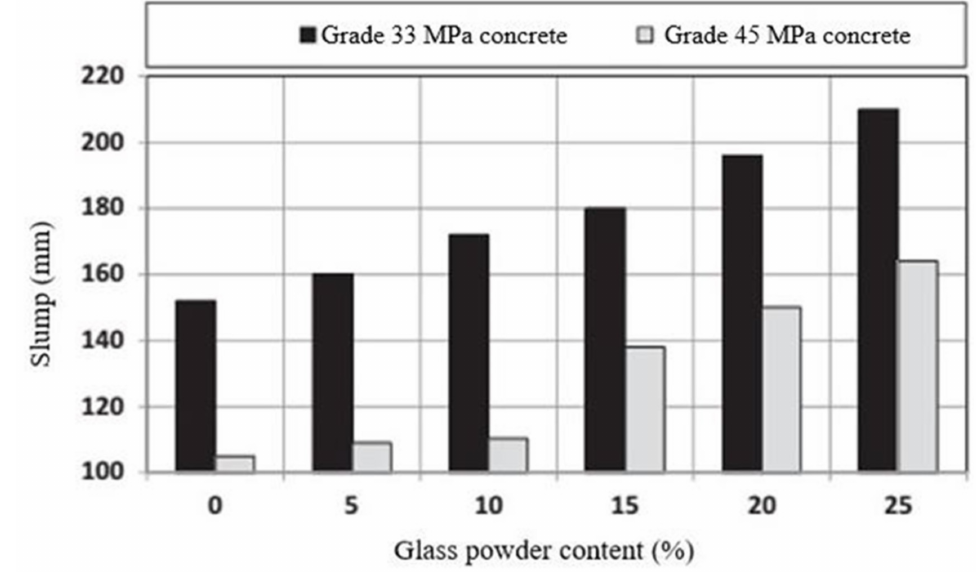
Figure 7. Slump values of concrete with WG powder (particle size ≤ 15 µ m)